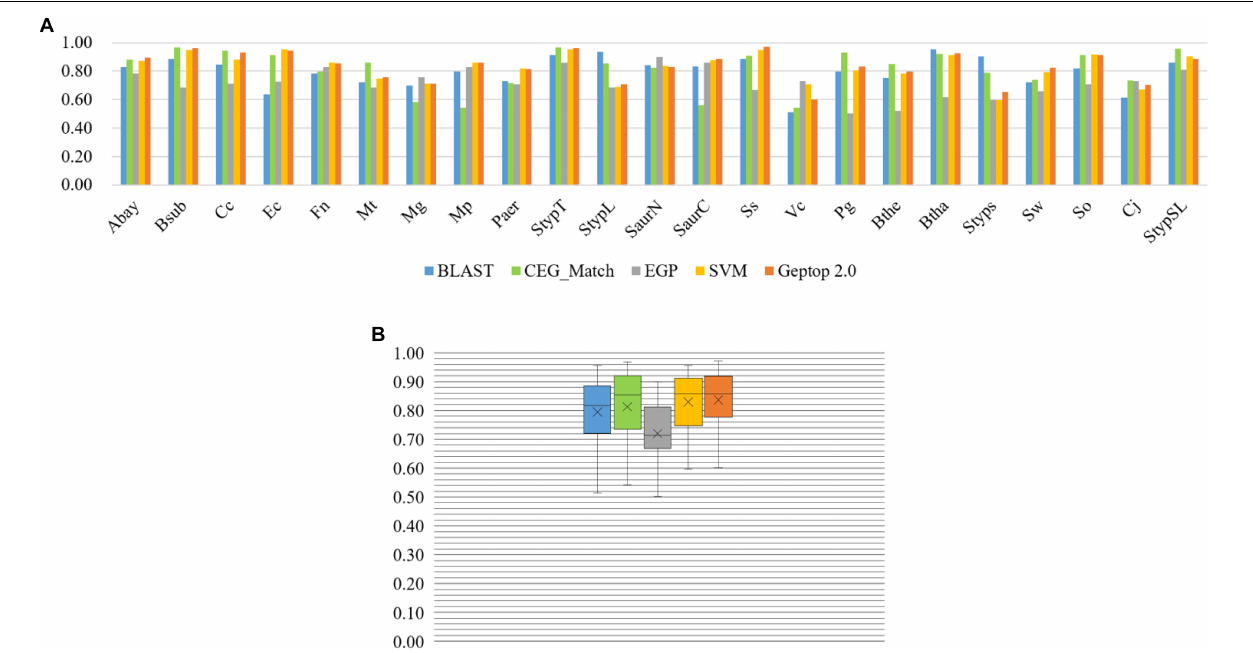
FIGURE 2 | Prediction performance of BLAST tool, CEG_Match, EGP, SVM, and Geptop 2.0 in the 23 genomes. (A) AUC scores of the gene essentiality prediction by BLAST tool, CEG_Match, EGP, SVM, and Geptop 2.0, respectively, for each genome. (B) Box plot of AUC scores from the prediction of the five tools for the 23 genomes.